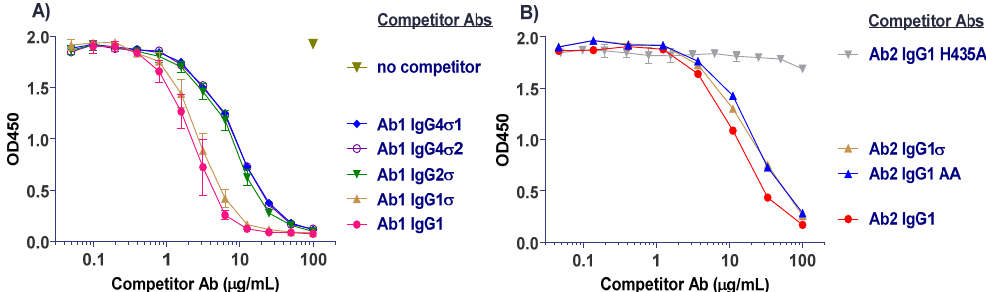
Figure 7. Binding of IgG variants to neonatal Fc receptor (FcRn). In a competition binding format, titrating amounts of antibody were combined with a fixed concentration (4 µ g/mL) of biotin-labeled huIgG1. Antibody mixtures were incubated with immobilized human FcRn on a plate for 1 h, washed, detected with streptavidin-horseradish peroxidase (HRP), and developed with tetramethylbenzidine (TMB) substrate. Bound tracer antibody was detected via absorbance at 450 nm measured on a plate reader. ( A ) Ab1 samples and ( B ) Ab2 samples were tested in duplicate and error bars represent mean ±